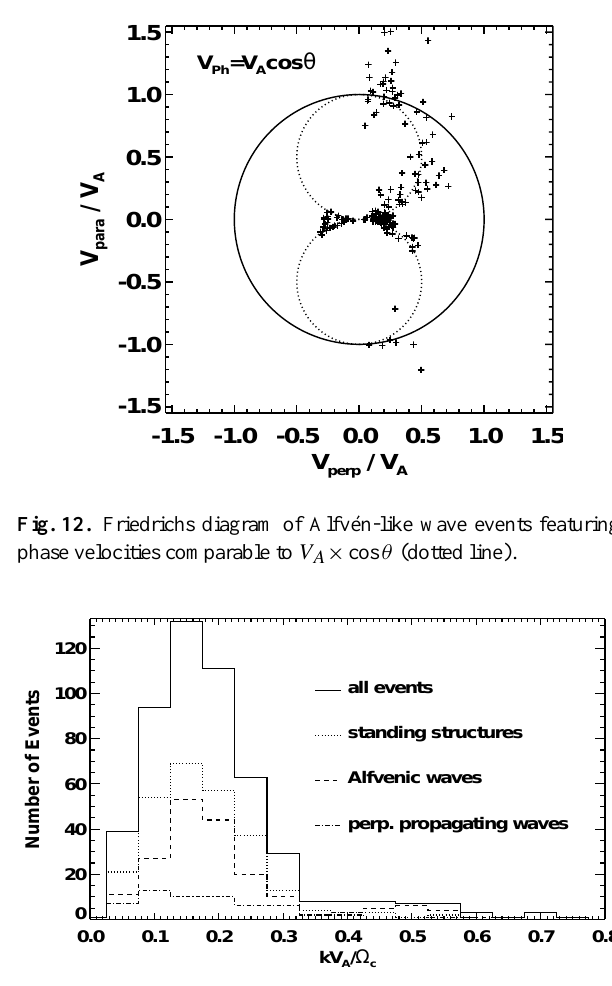
Fig. 13. Wave number histograms of all wave events and of different wave